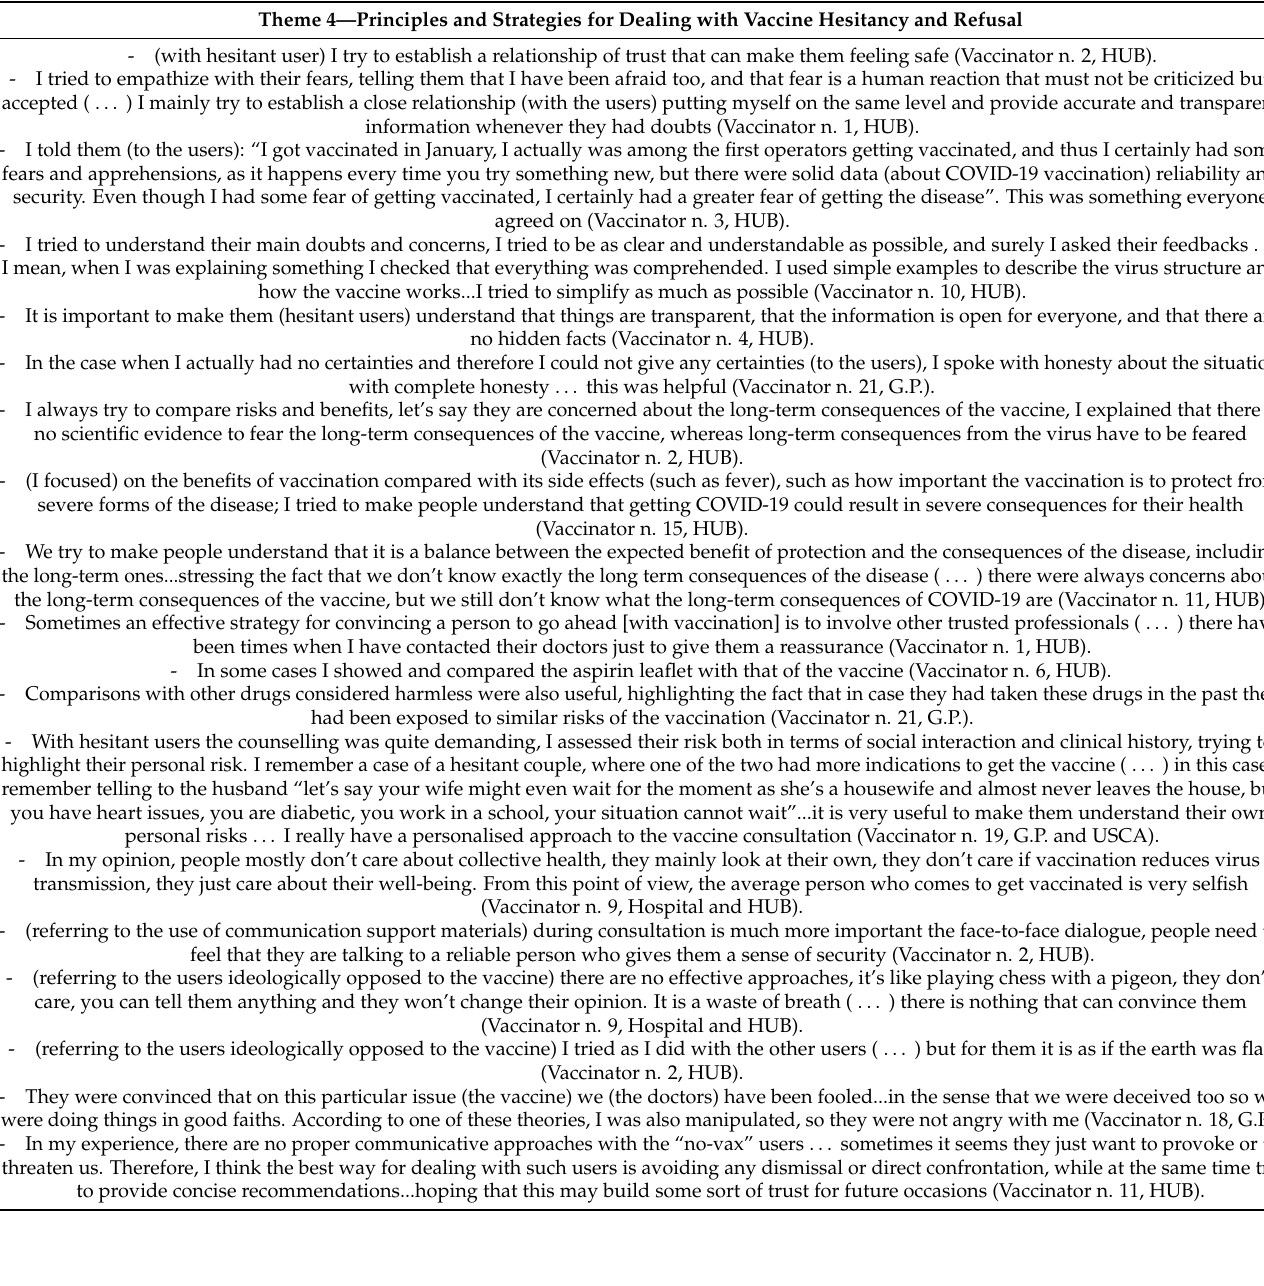
Table 6. Illustrative quotes for theme 4, “principles and strategies for dealing with vaccine hesitancy and